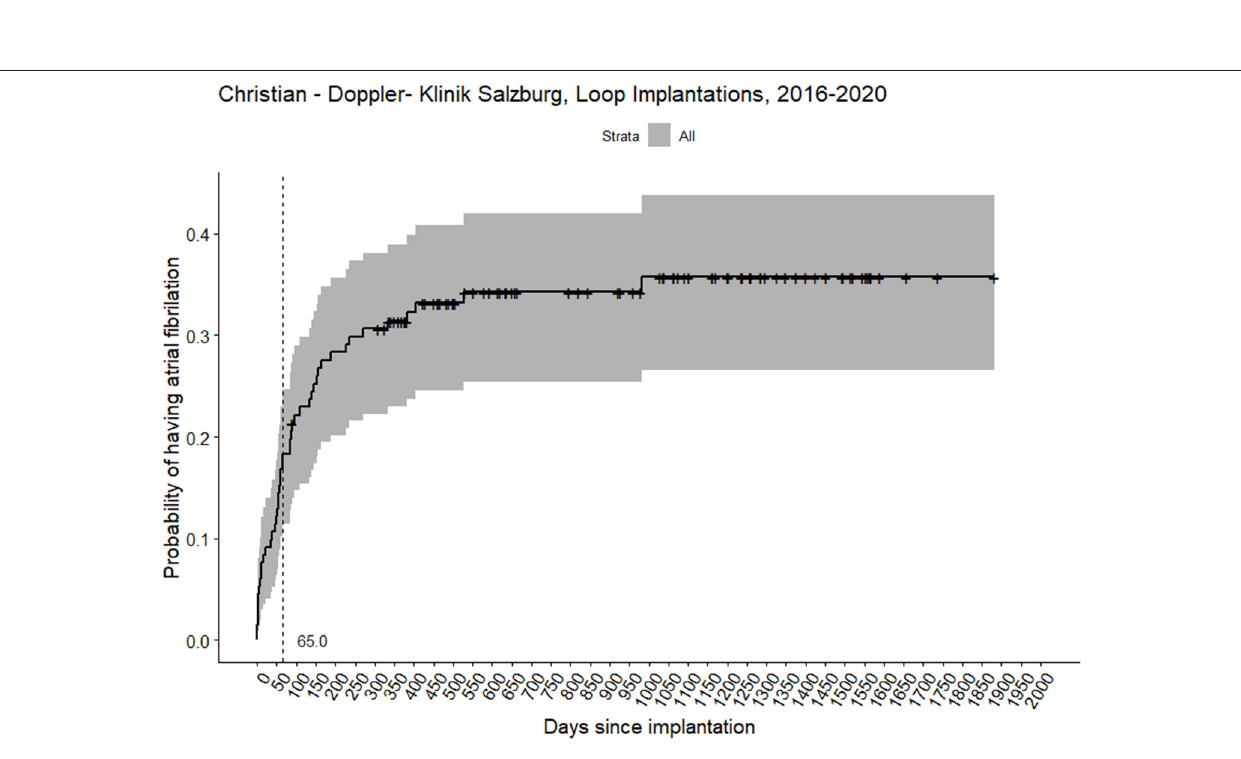
Frontiers in Neurology |